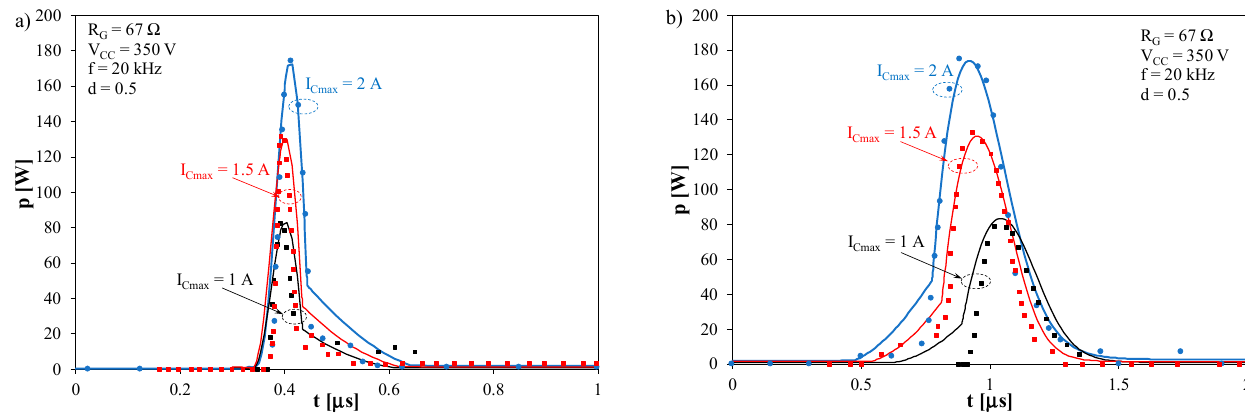
Figure 8. Computed and measured waveforms of power lost in the tested transistor at switching-on ( a ) and switching-off ( b ). In Figure 9, the computed and measured dependences of the case temperature of the transistor without any heat-sink operating in the considered switch with resistive load on current I Cmax are shown. The presented results were obtained at frequency of the control signal f = 20 kHz and selected values of the duty cycle d.